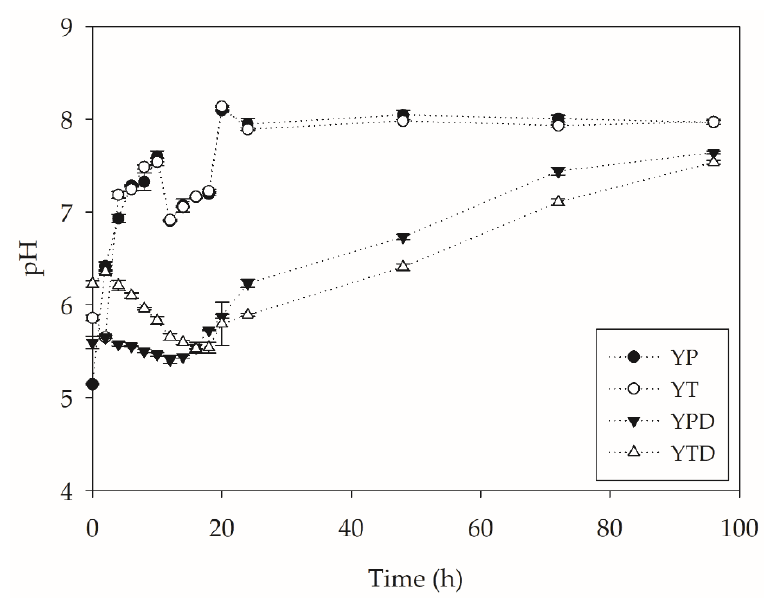
Figure 6. pH variations during PC-PET biodepolymerization by submerged cultures of Y. lipolytica IMUFRJ 50682 at 28 °C and 250 rpm for 96 h.